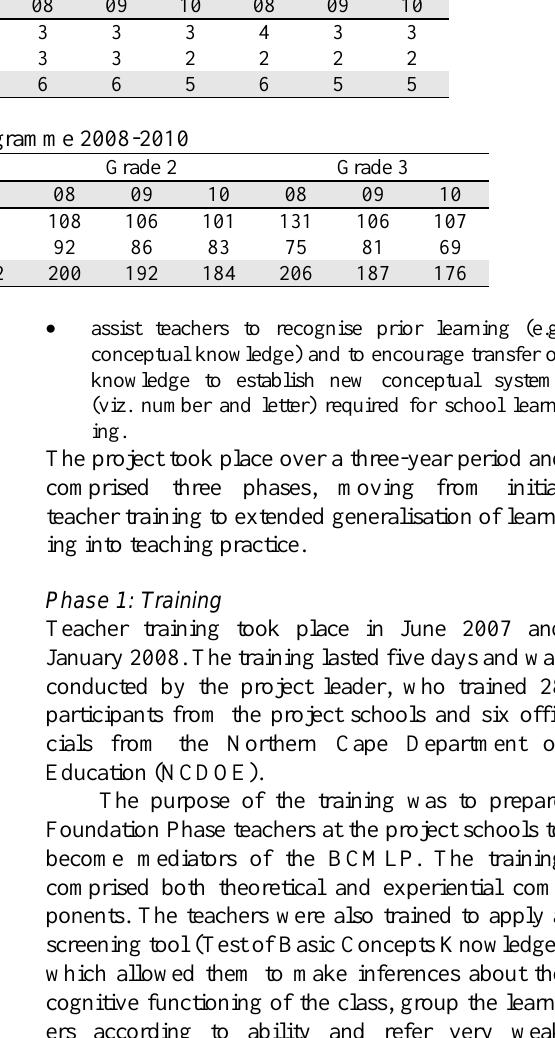
Table 1 Number of teachers who participated in the programme 2008-2010 Teachers